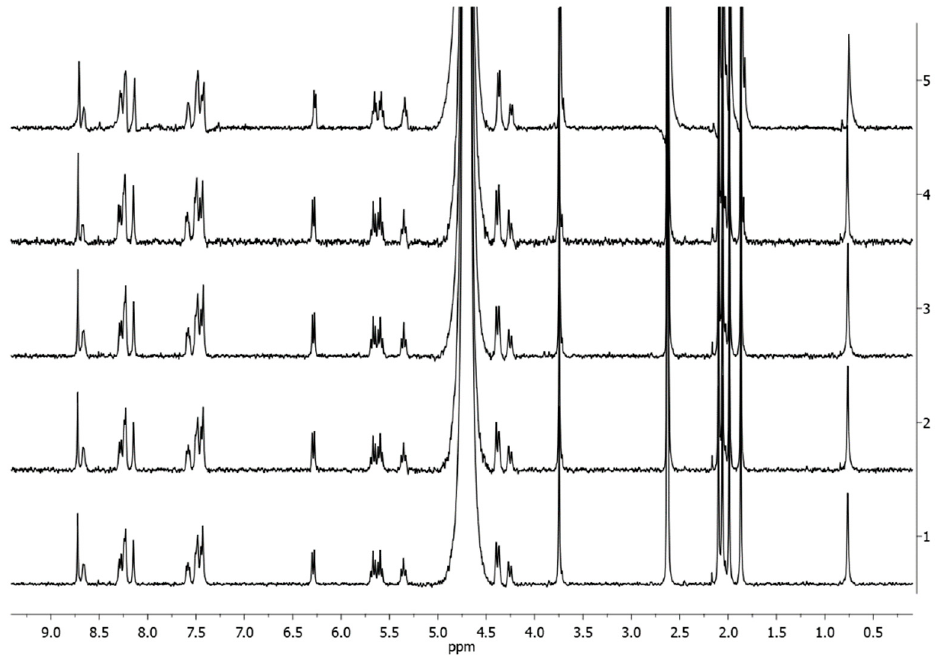
Figure 5. 1 H-NMR spectra of 4Pt-im in 9:1 v/v PB:DMSO- d 6 (1 mM) at 37 °C at different times (1 = start, 2 = 1 h, 3 = 3 h, 4 = 24 h, 5 = 48 h).